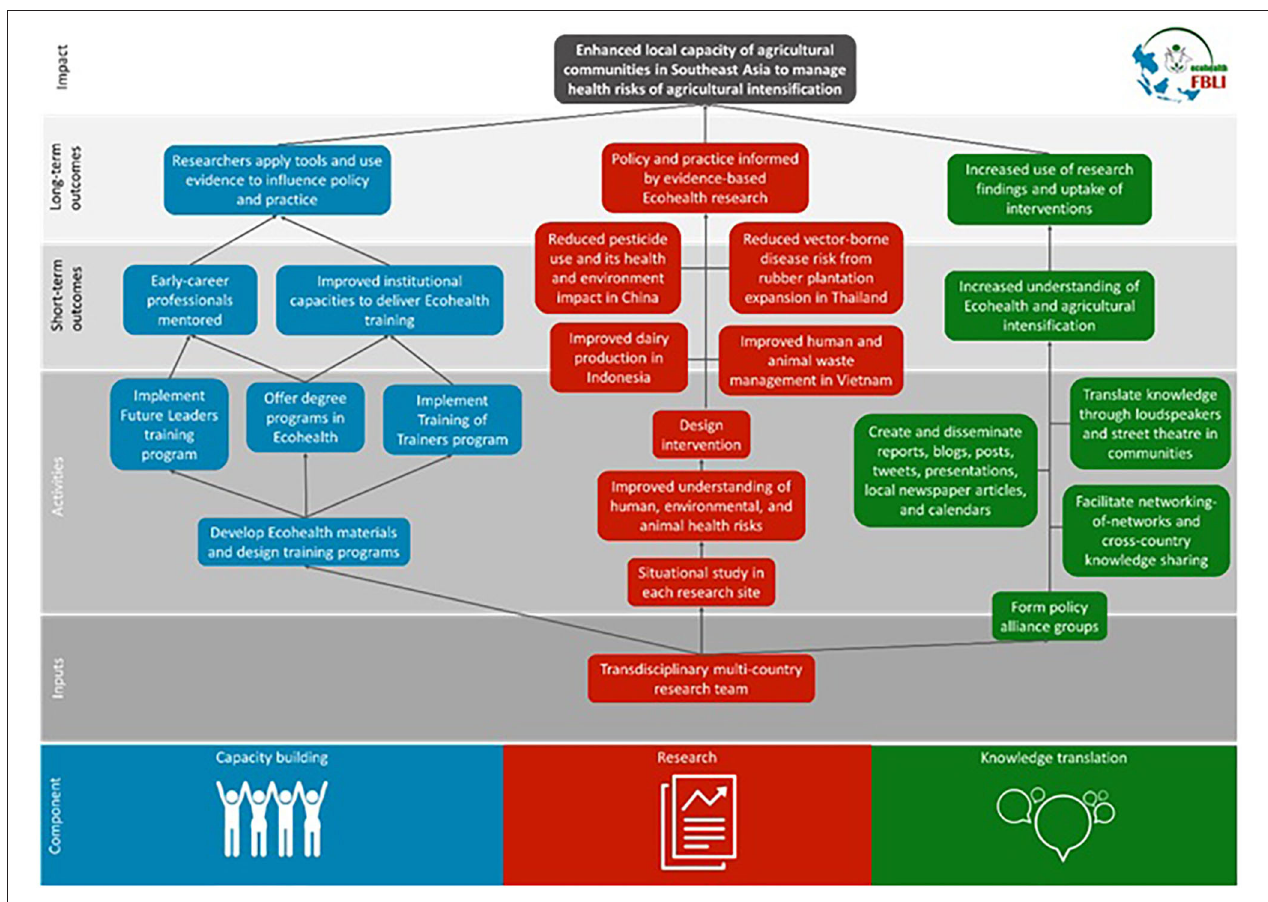
FIGURE 1 | Impact pathway of Ecohealth projects in China, Indonesia, Thailand, and